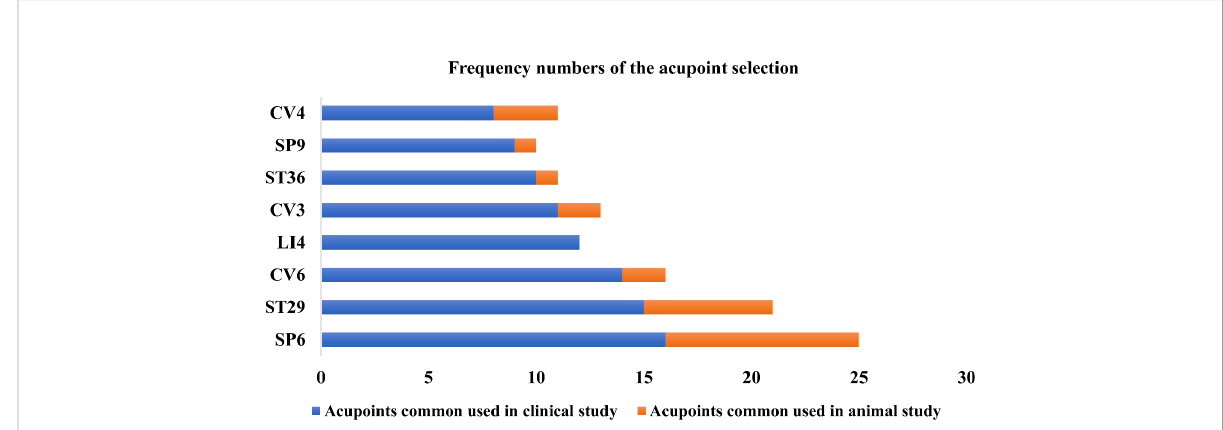
FIGURE 6 The use frequency of acupoints. SP6 (Sanyinjiao) and ST29 (Guilai) are the most frequently stimulated two acupoints both in animals and humans with polycystic ovary